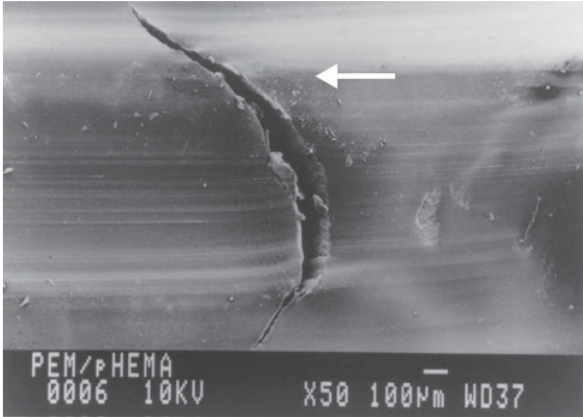
hydrogel by reinforcing the network with CAB and PEM